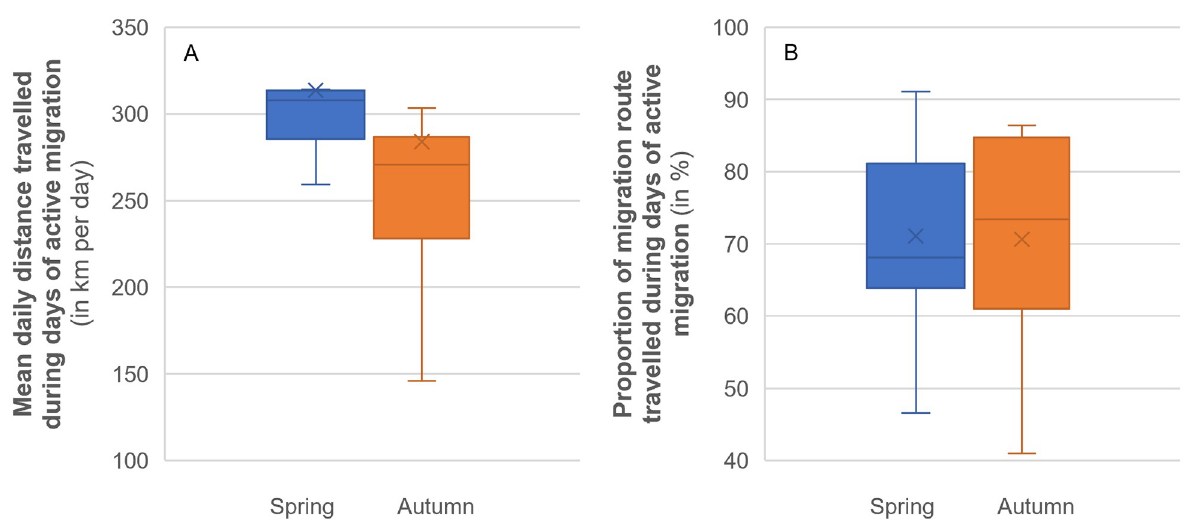
Fig 6. Daily distances (left) and proportion of the migration route travelled during days of active migration (right) by 13 Vega gulls in spring (blue) and autumn (ochre). Boxes hold 50% of the values, with the median shown as a horizontal line and the mean as an ‘x’. Whiskers extend to the highest and lowest values excluding